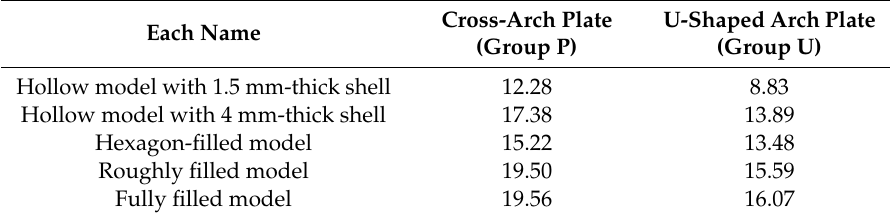
Table 1. Resin consumption according to model design (units: ml).